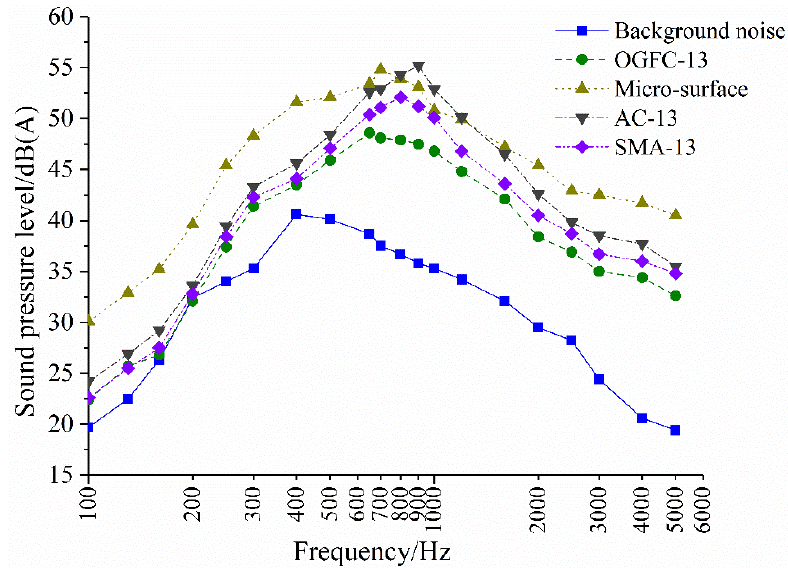
Figure 9. Noise frequency diagram of different pavement types.